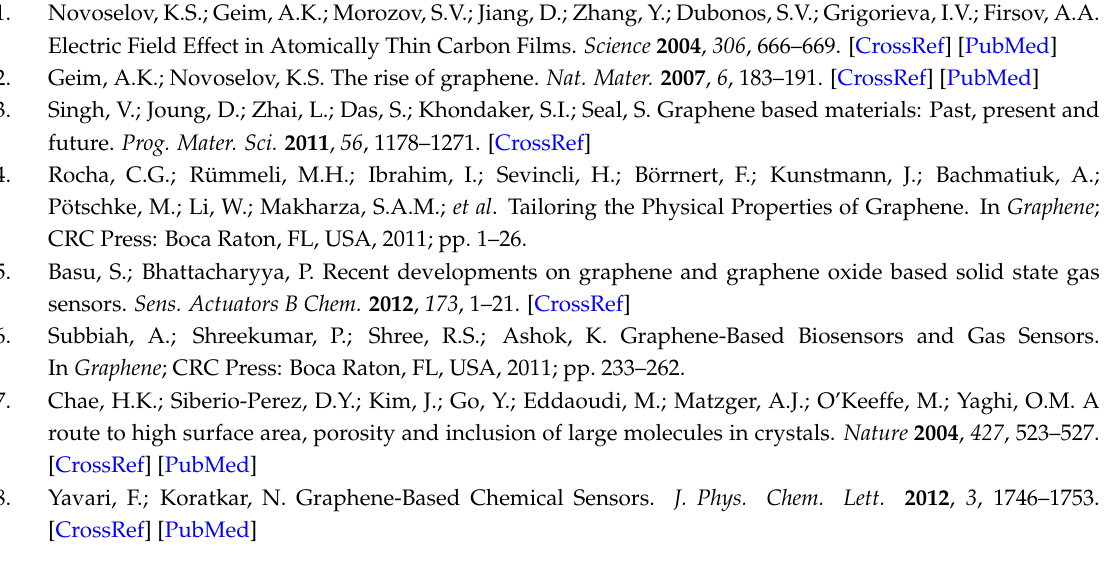
Table 3 highlights the sensing performance of graphene metal/metal oxide based gas sensors. The hydrogen gas sensor fabricated by incorporating Pd-WO 3 nanostructures in GO and partially reduced graphene oxide (PRGO) expressed a detection range of 20–10,000 ppm with a response/recovery time of <1 min. Whereas, a higher sensor response of 89.3% towards